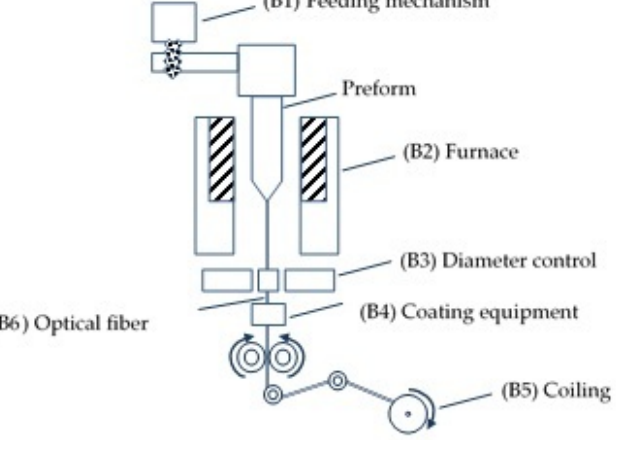
Figure 1. Scheme of the drawing tower.